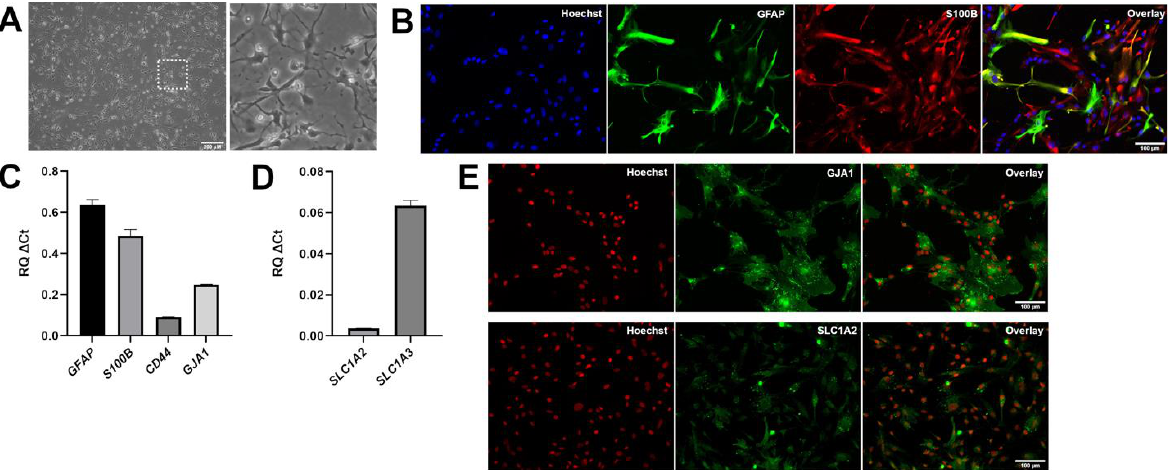
Figure 2. Characterization of astrocytes generated from ventralized and caudalized neural progen- itor cells. ( A ) Phase contrast image of DIV80 astrocytes derived from ventralized and caudalized NPCs, showing that most cells have stellate-like morphologies with long and thin extensions. Box in left-hand panel indicates area shown at higher magnification in right-hand panel. ( B ) Representa- tive double-labeling immunofluorescence analysis of GFAP (green) and S100B (red) expression in DIV80 astrocytes; Hoechst counterstaining (blue) is shown. The majority of induced cells express S100B, and a significant proportion of S100B-positive cells co-express GFAP at high level, while other S100B-positive cells co-express GFAP at low level. ( C , D ) Real-time PCR analysis of the expres- sion of GFAP , S100B , CD44 , GJA1 ( C ), as well as SLC1A2 and SLC1A3 ( D ) in induced astrocytes. ( E ) Immunofluorescence analysis of GJA1 and SLC1A2 (green) expression in DIV80 astrocytes gener- ated from ventralized and caudalized NPCs; Hoechst counterstaining (red) is shown.